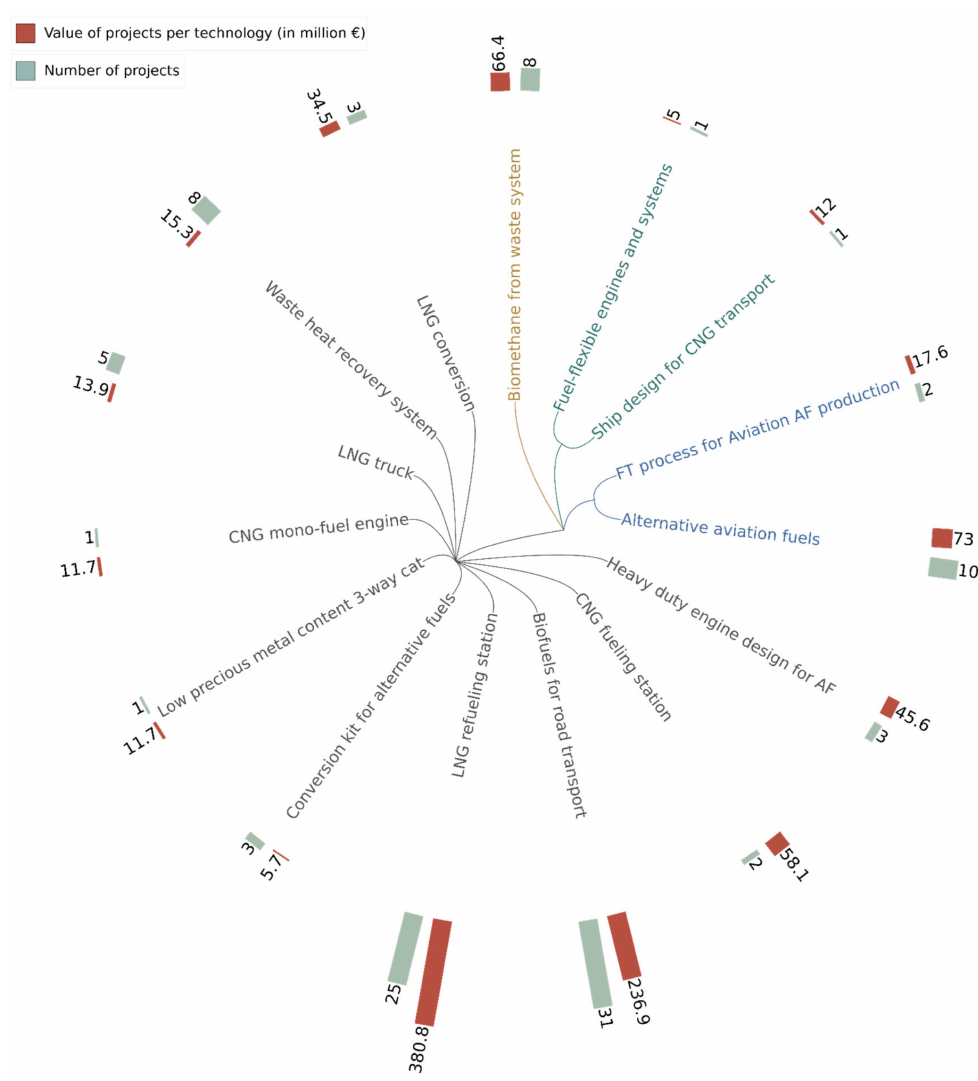
Figure 2. Overall top 15 technologies. Source [10]. Bars not in scale. (LNG: Liquefied natural gas; AF: Alternative Fuel; CNG: Compressed natural gas; FT: Fischer-Tropsch). Brown branches: road transport; blue branches: aviation; green branches: waterborne transport; dark yellow: multi- modal